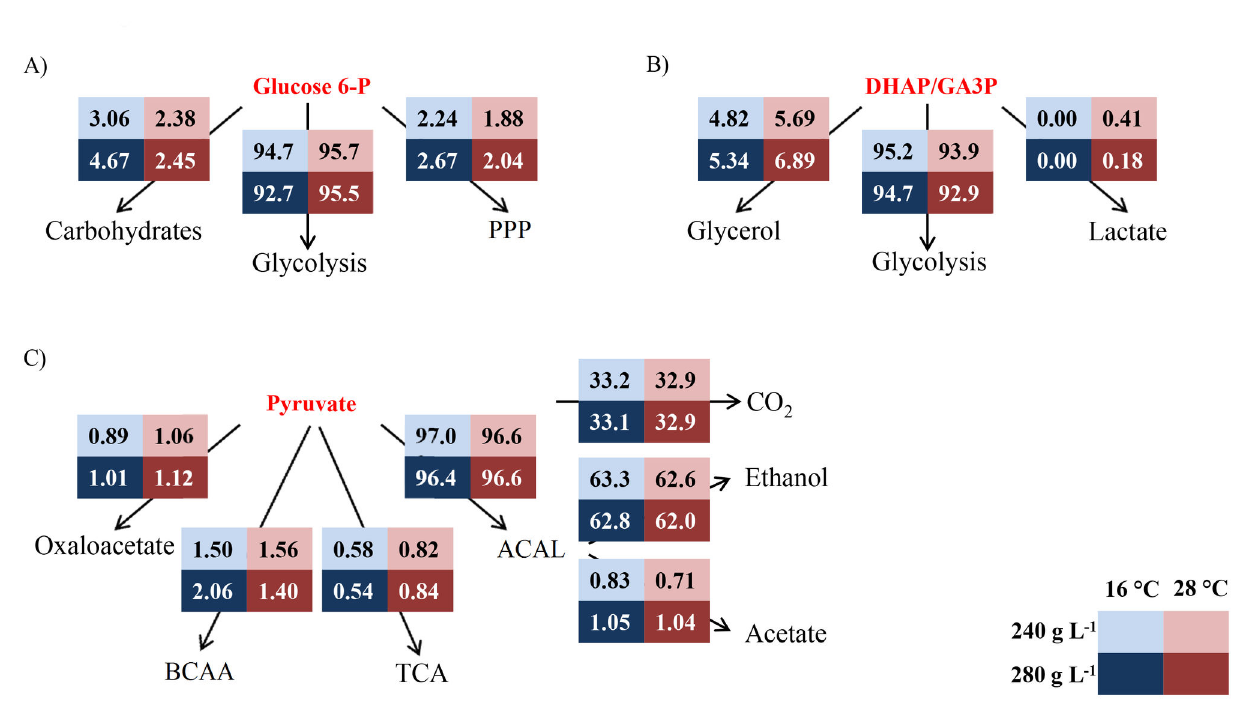
Figure 3. Flux distribution at different nodes. A) Glucose 6-P branch point; B) Trioses phosphate node; C) Pyruvate branch